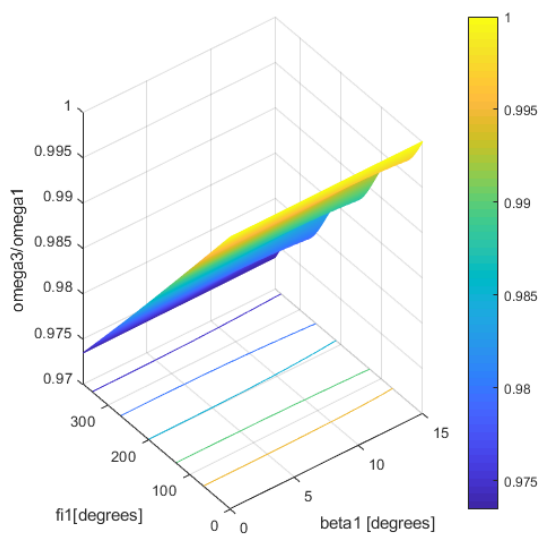
Figure 12. Kinematic nonuniformity of isometry for automotive driveshaft for r 1 /l = 0.11, r 2 /l = 0.09, β 1 = 15°.